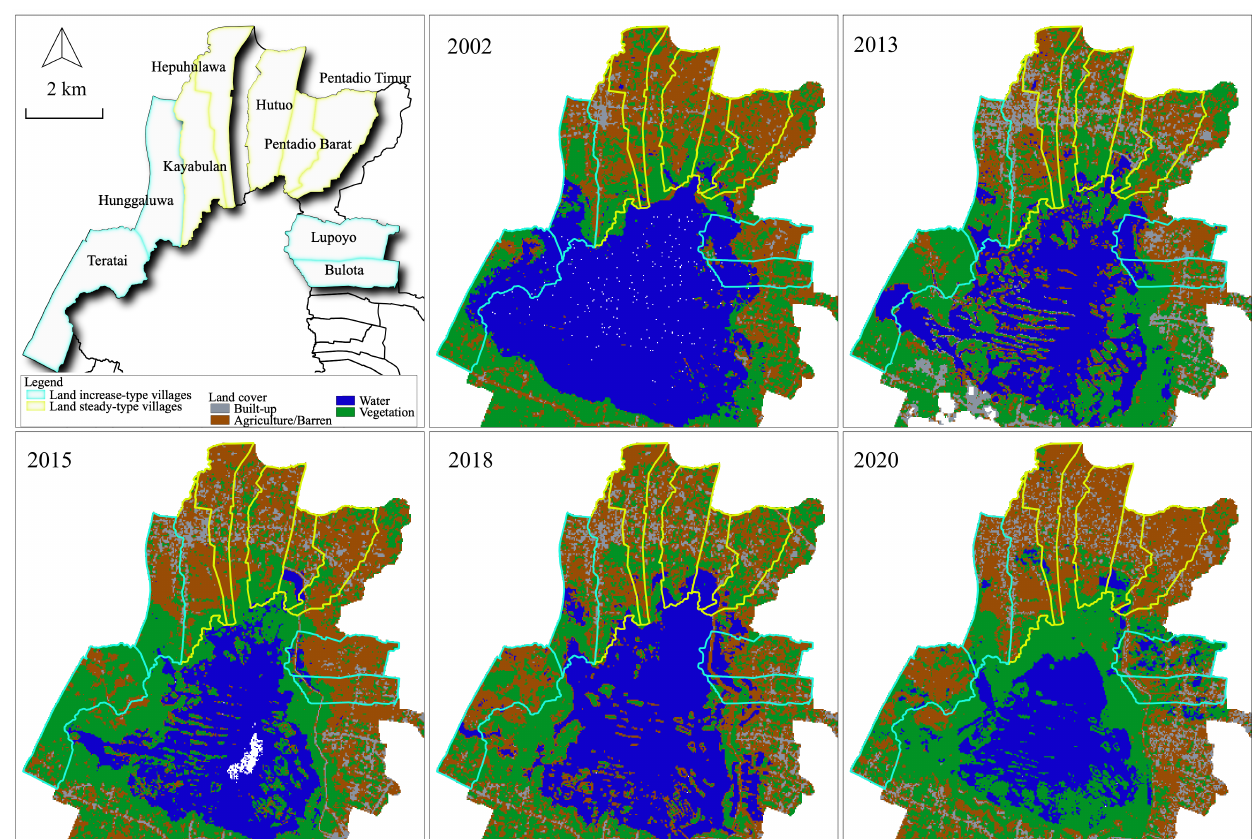
Figure 3. Land cover classification results of land increase-type villages and land steady-type villages from the random forest model using Landsat